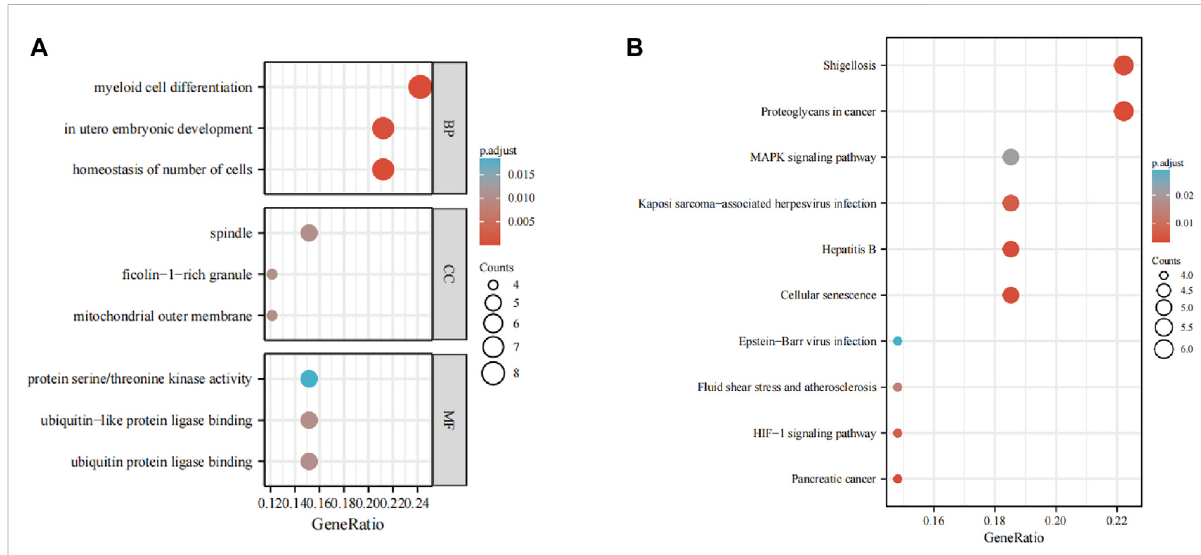
FIGURE 3 Enrichment analyses of (A) function of differentially expressed genes (DEGs) using the Gene Ontology database and (B) signaling pathways of DEGs using the Kyoto Encyclopedia of Genes and Genomes